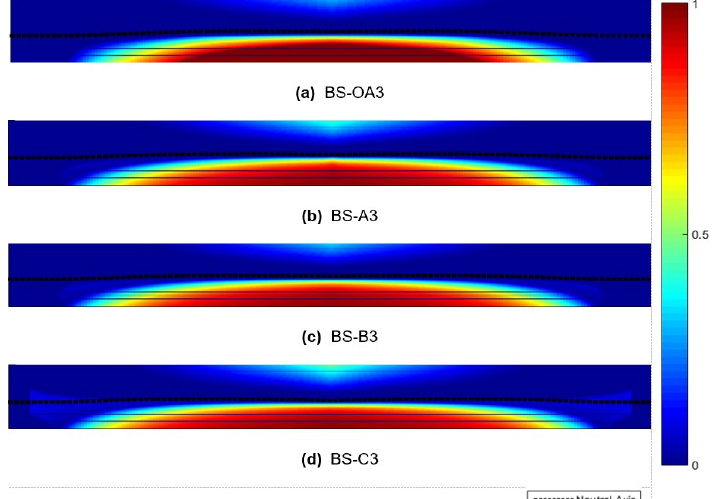
Figure 12. Final damage configuration for Bresler-Scordelis' series 3